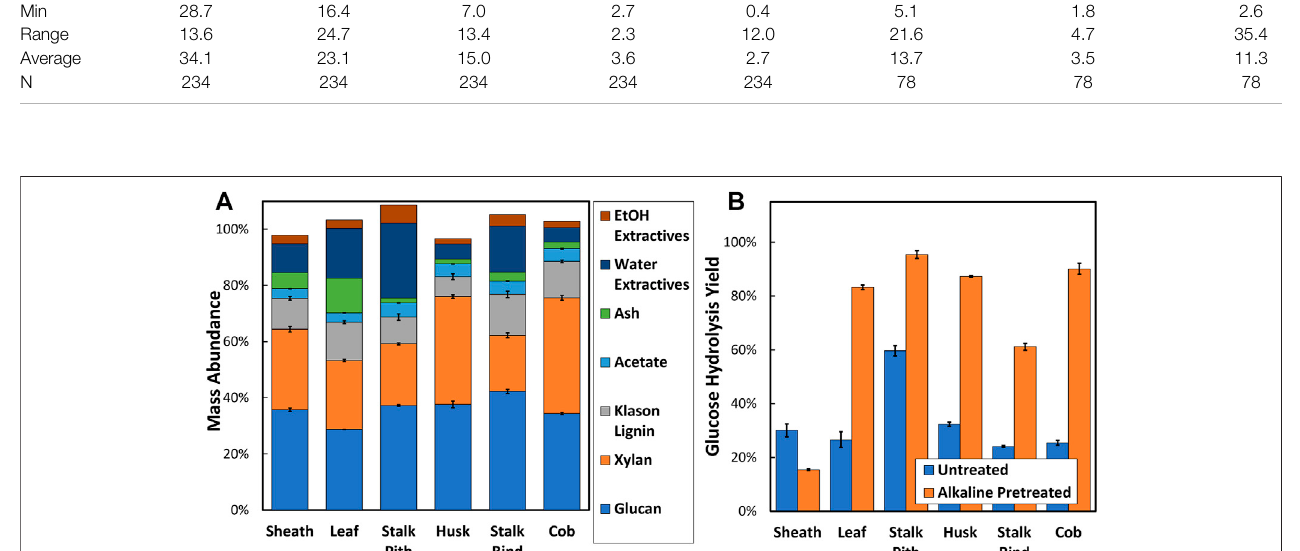
FIGURE2|(A) Compositionofmanually sorted anatomical tissues ofcorn stoveronadry basisand (B) glucose hydrolysis following enzymatic hydrolysis (as%of theoretical maximum) for anatomical tissues of untreated corn stover and those pretreated under alkaline conditions.